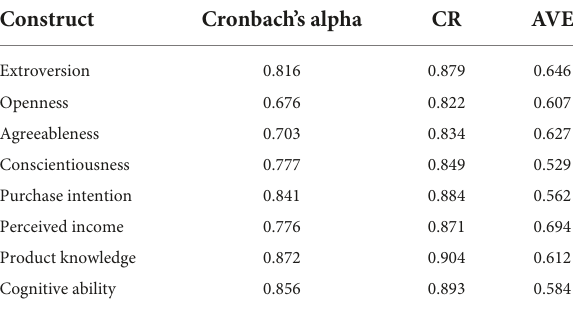
TABLE 2 Construct reliability and